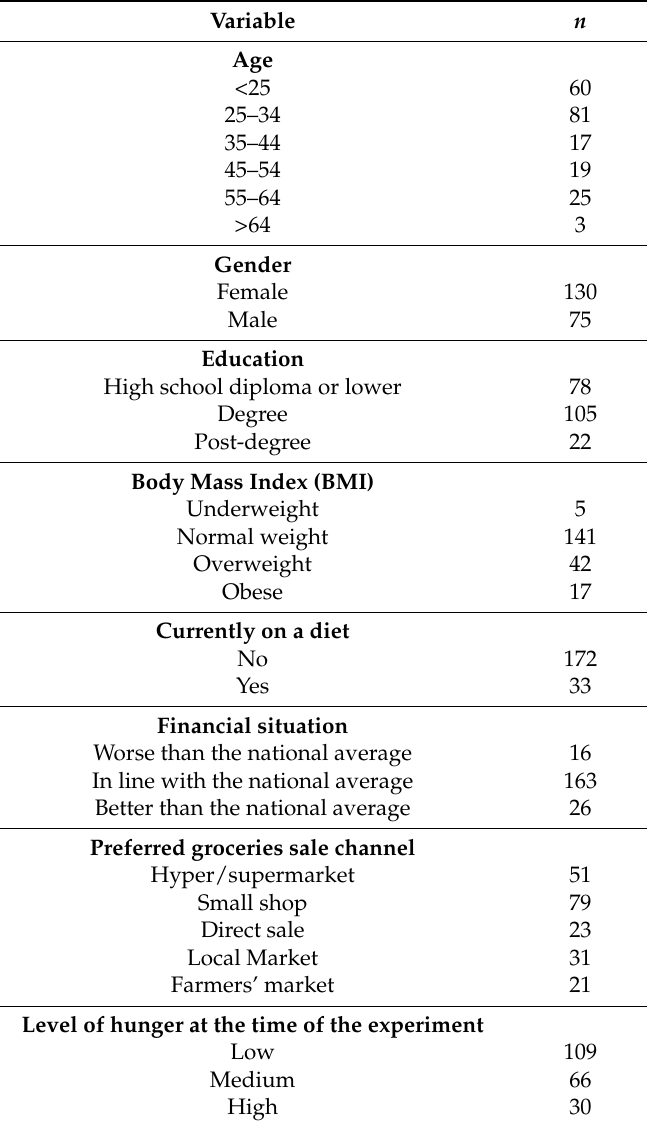
Table 2. Characteristics of